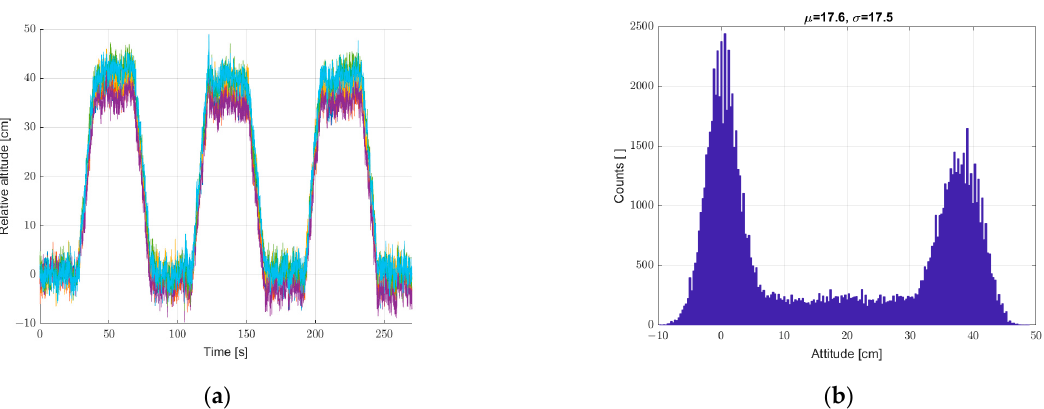
Figure 10. Graph over time from ( a ) 6 + 1 sensors, and ( b ) histogram. Dynamic measurements— sensor array in motion.